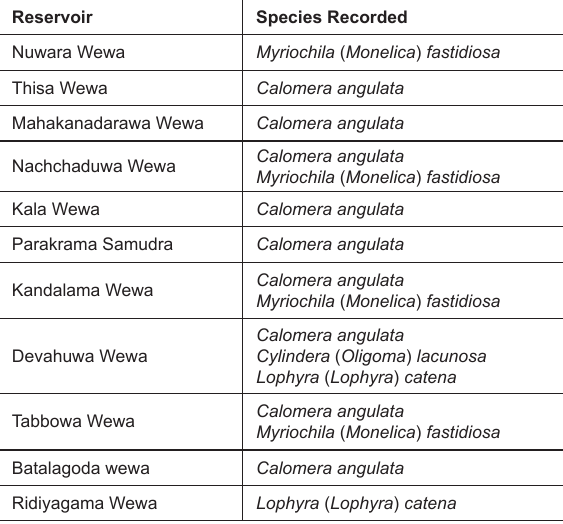
Table 2. Reservoirs ecosystems of Sri Lanka and associated tiger